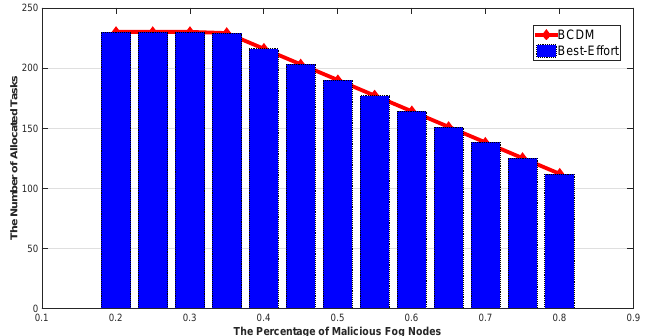
0.2 The Percentage of Malicious Fog Nodes Figure 16. The Impact of Percentage of Malicious Fog Nodes to Total Energy Consumption.